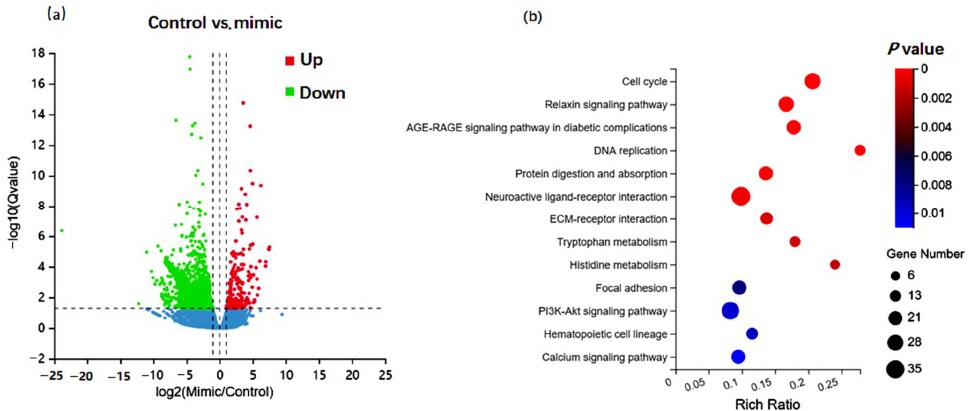
Figure 4. Differentially expressed mRNAs after chi-miR-99b-3p up-regulation. ( a ) A volcano plot representing DEGs after chi-miR-99b-3p overexpression ( b ) Functional enrichment analysis of DE genes.